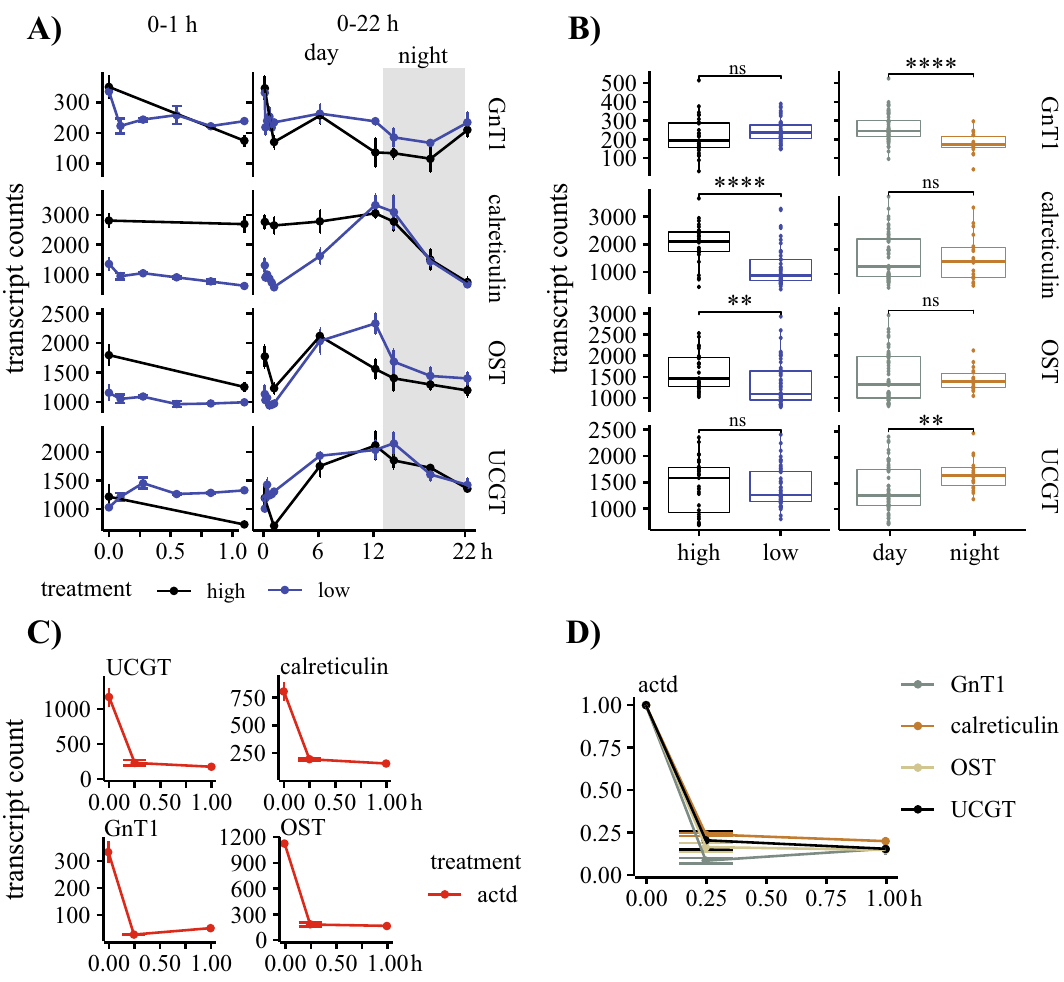
Figure 4. Analysis of transcript dynamics of selected enzymes involved in the N-linked glycosylation pathway. ( A ) Transcript dynamics of N-acetylglucosaminyltransferase I (GnT1), calreticulin, oligosaccharyltransferase (OST), and UDP-glucose glucosyltransferase (UGGT). High-iron samples are shown in black, and low-iron samples are in blue. The left panel shows transcript counts of the first hour, and the right side shows transcript counts over the 22 h period. The dark period is highlighted in grey. ( B ) Boxplots for each target, analyzing statistical variance between high/low (left) and night/day (right) samples. Student’s t-test was used as a significance test. ( C ) Transcript counts of the first hour after the samples were treated with actinomycin D (actD). ( D ) The normalized samples are shown below, with the highest transcript count for each transcript equal to 1. GnT1 is grey, calreticulin orange, OST bright brown, and UGGT dark